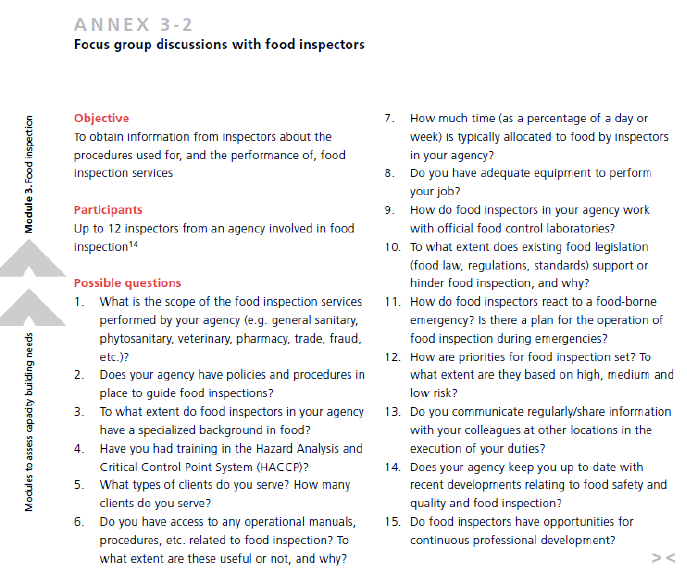
Figure A2. Discussion questions for City Health Office and sanitation inspectors.